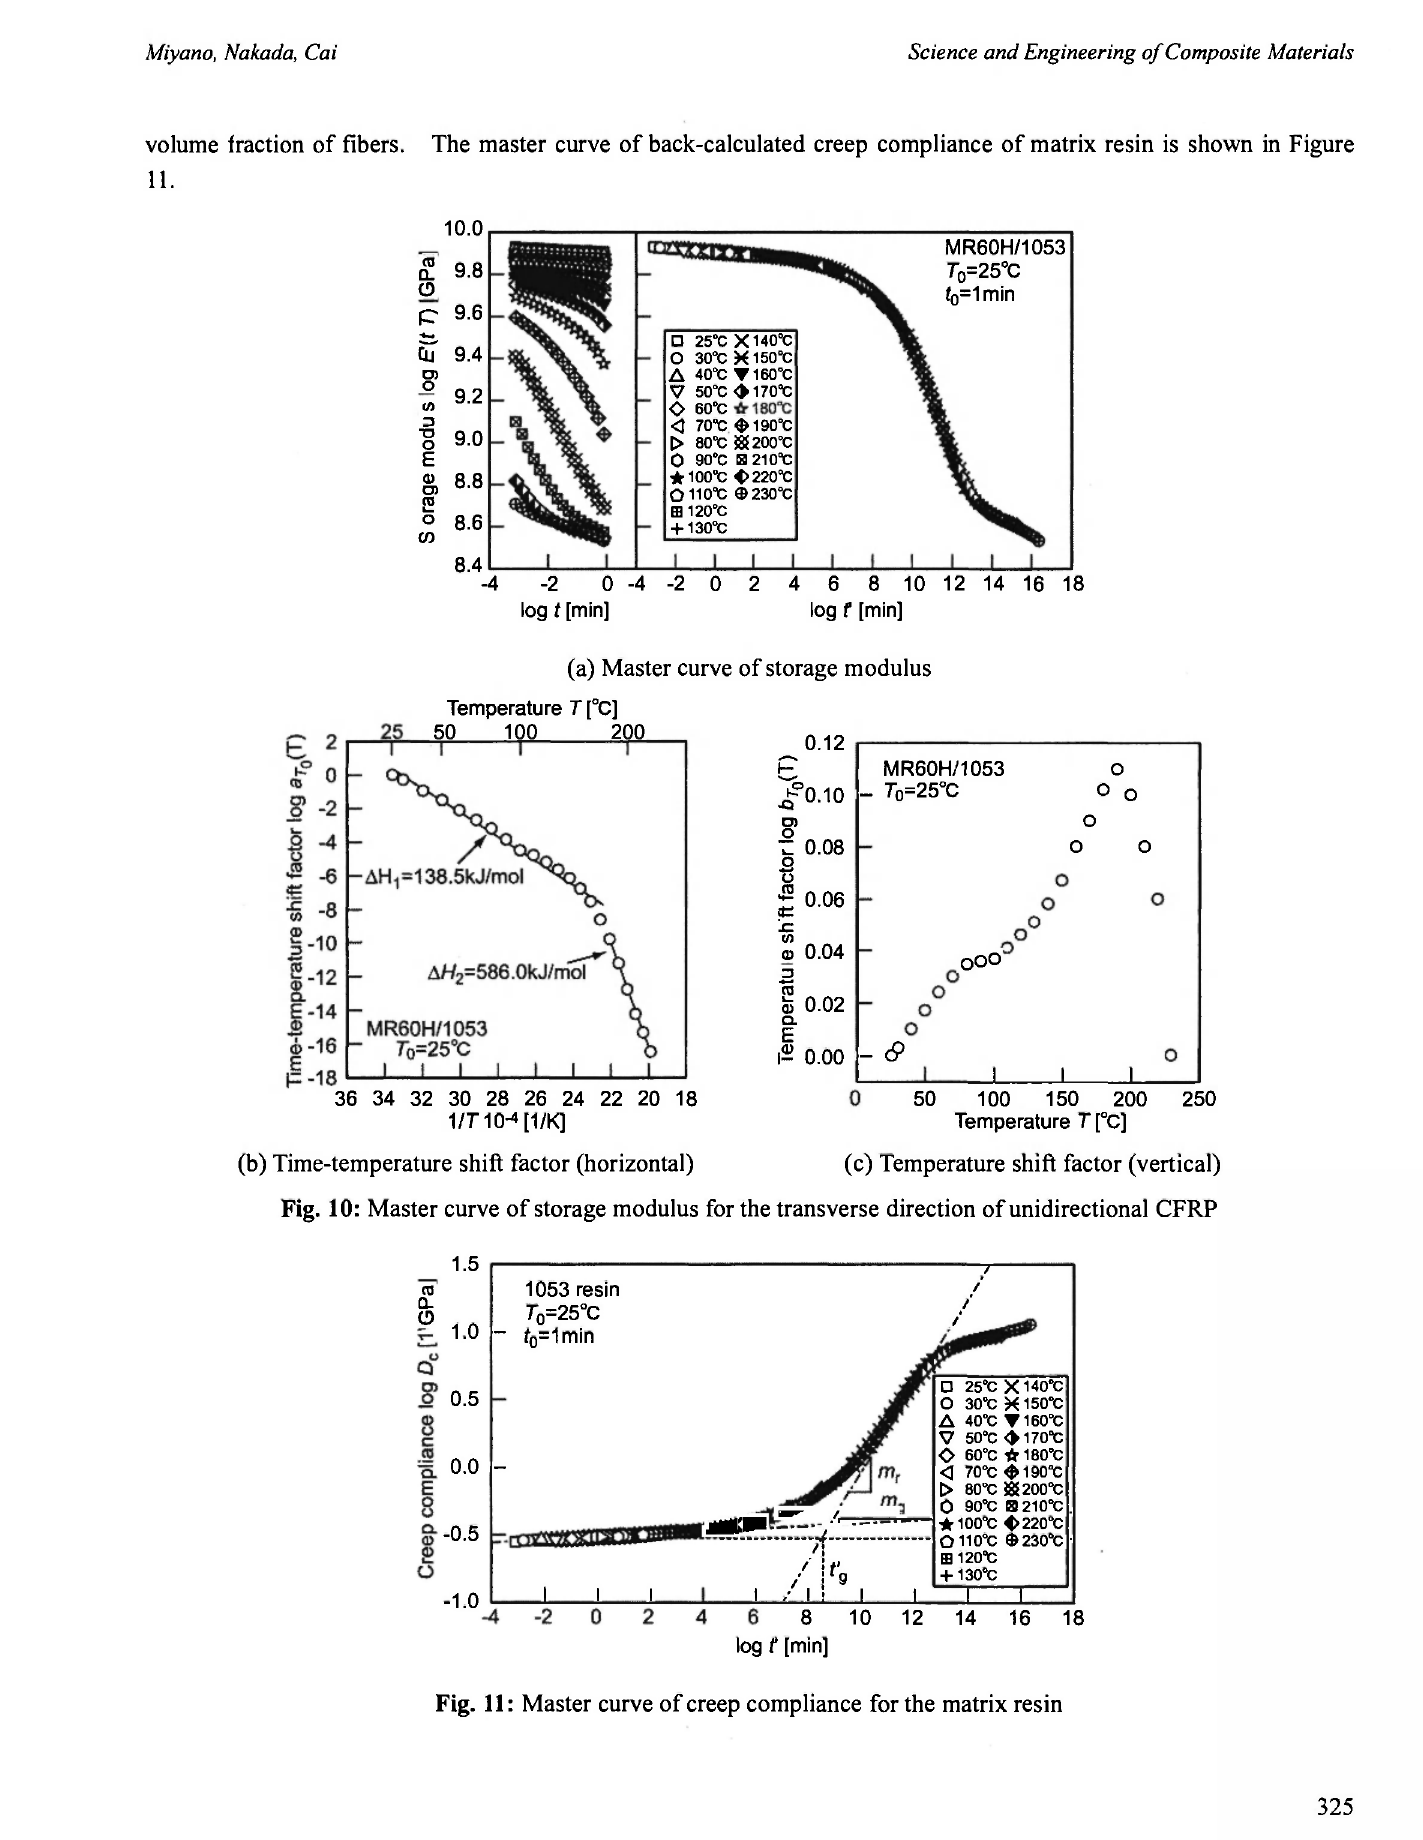
Fig. 11: Master curve of creep compliance for the matrix